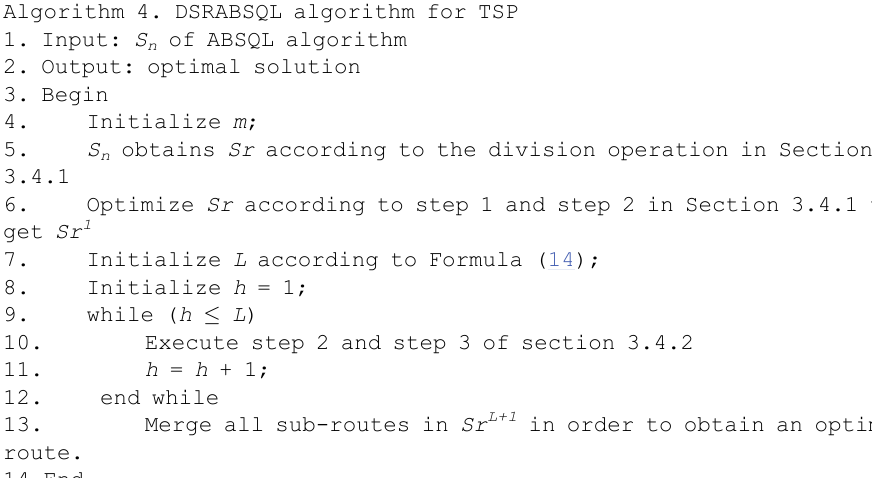
Algorithm 4. DSRABSQL algorithm for